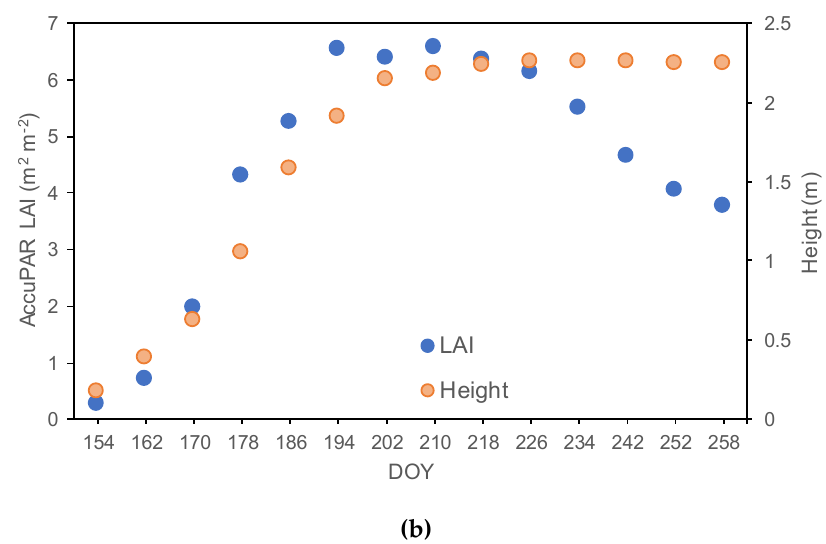
Figure 8. ( a ) Relationship between average crop height and average LAI. ( b ) Seasonal progression of crop height (ten reading average for each location) and LAI measured with AccuPAR (average of five locations, each location with five points and five replications per location) throughout the 2016 growing season.